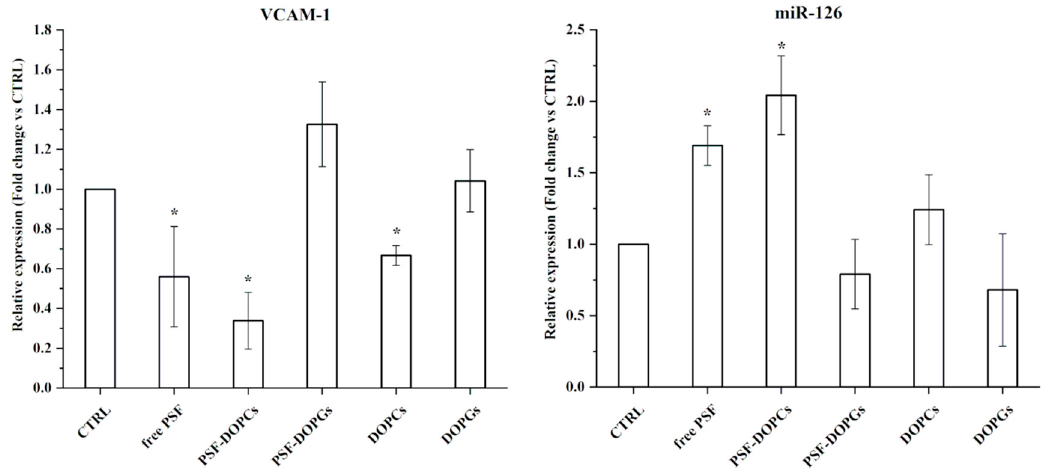
Figure 6. Effect of free P. spinosa fruit extract (free PSF), incorporated extract (PSF-DOPCs and PSF-DOPGs) and empty vesicles (DOPCs and DOPGs) on the VCAM-1 and miR-126 (cell adhesion molecules target). RT–qPCR values are reported as fold induction related to CTRL. Two-tailed paired Student’s t -test: * = p < 0.05.